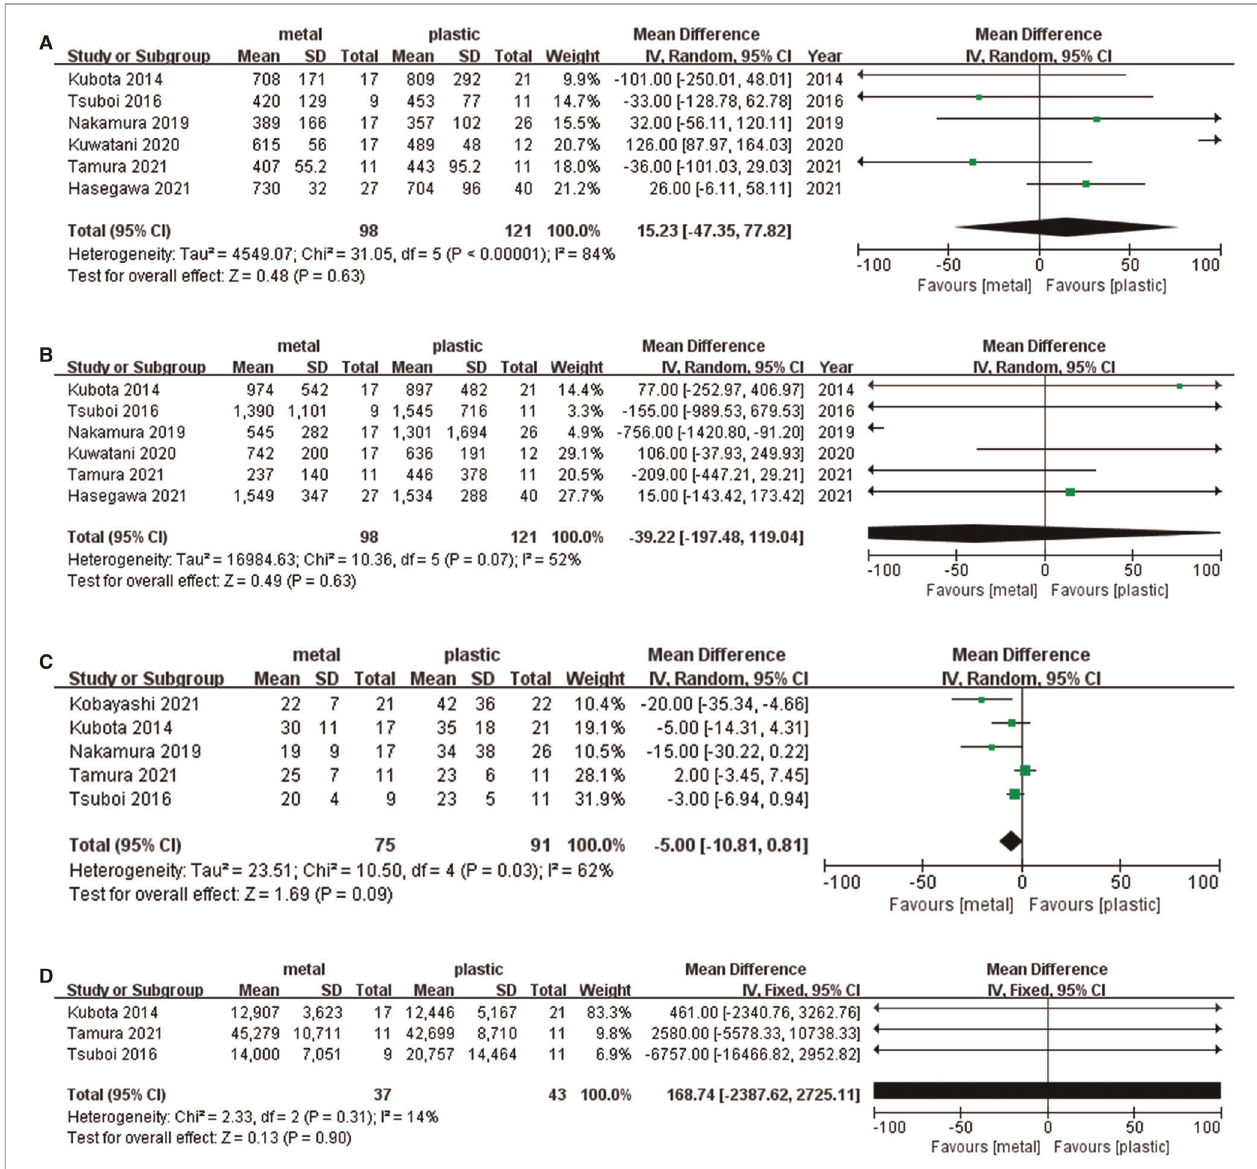
FIGURE 4 | Forest plot of ( A ) Operative time; ( B ) Operative blood loss; ( C ) Postoperative hospitalization days; ( D ) Total medical cost.